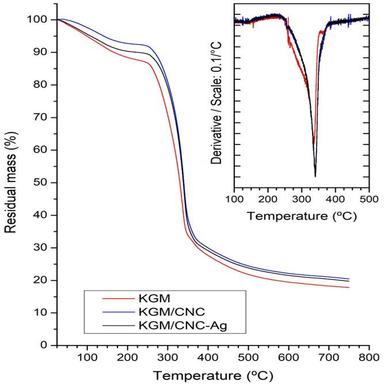
TGA and differential TGA (inset) thermograms of KGM, KGM/CNC and KGM/CNC-Ag.